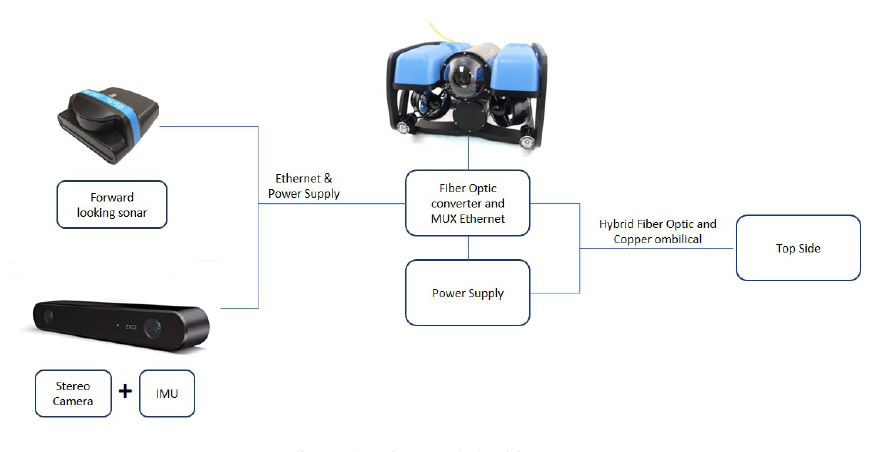
Figure 1. BlueRov2 Architecture